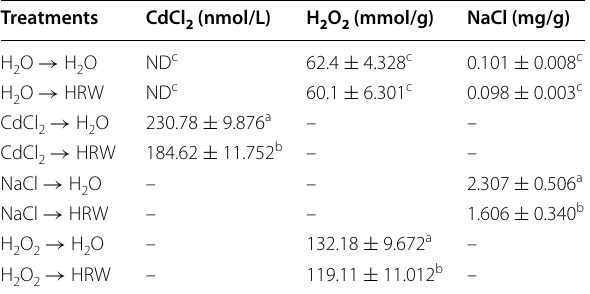
Table 1 Effects of HRW treatment on CdCl concentrations in mycelia of H. marmoreus